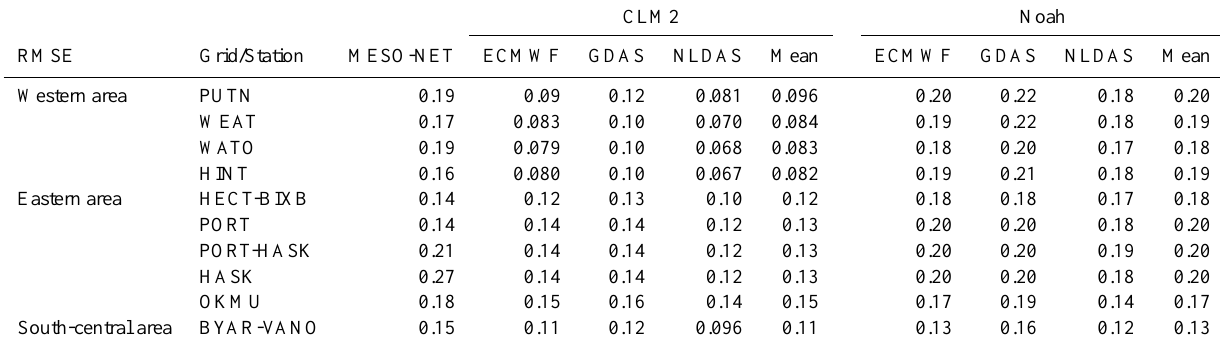
Table 2. RMSE (m 3 m − 3 ) of the UoM soil moisture product vs. ground-observed and modelled soil moisture estimates. CLM2